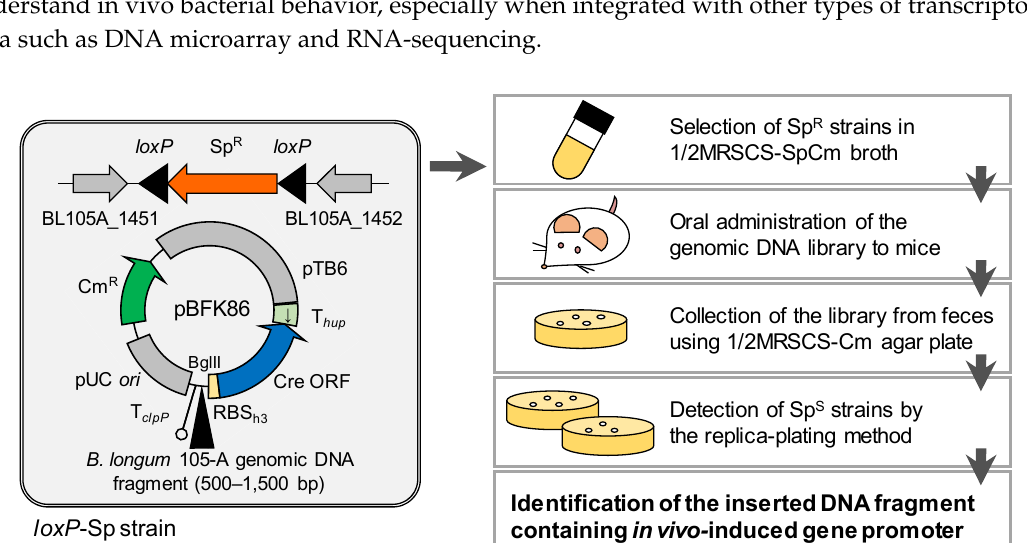
Figure 1. Overview of the recombinase-based in vivo expression technology (R-IVET) system constructed in this study. The loxP -Sp strain harbored a loxP -Sp R - loxP cassette that was inserted between BL105A_1451 and BL105A_1452 on the chromosome of B. longum 105-A. Random DNA fragments of B. longum 105-A were independently inserted upstream of the promoterless Cre gene in pBFK86. The resulting plasmids were introduced into the loxP -Sp strain, generating the genomic DNA library consisting of ~120,000 clones. The library was cultured in Sp-containing medium to exclude Sp S strains in which the Cre gene was expressed by the DNA fragment with in vitro promoter activity. The library was then administered orally to mice and collected from feces. Finally, the Sp S strains in which the Cre gene had been expressed during passage through the gastrointestinal tract were identified to determine in vivo-induced gene promoters. Sp R , spectinomycin resistance; Sp S , spectinomycin sensitive; Cm R , chloramphenicol resistance.